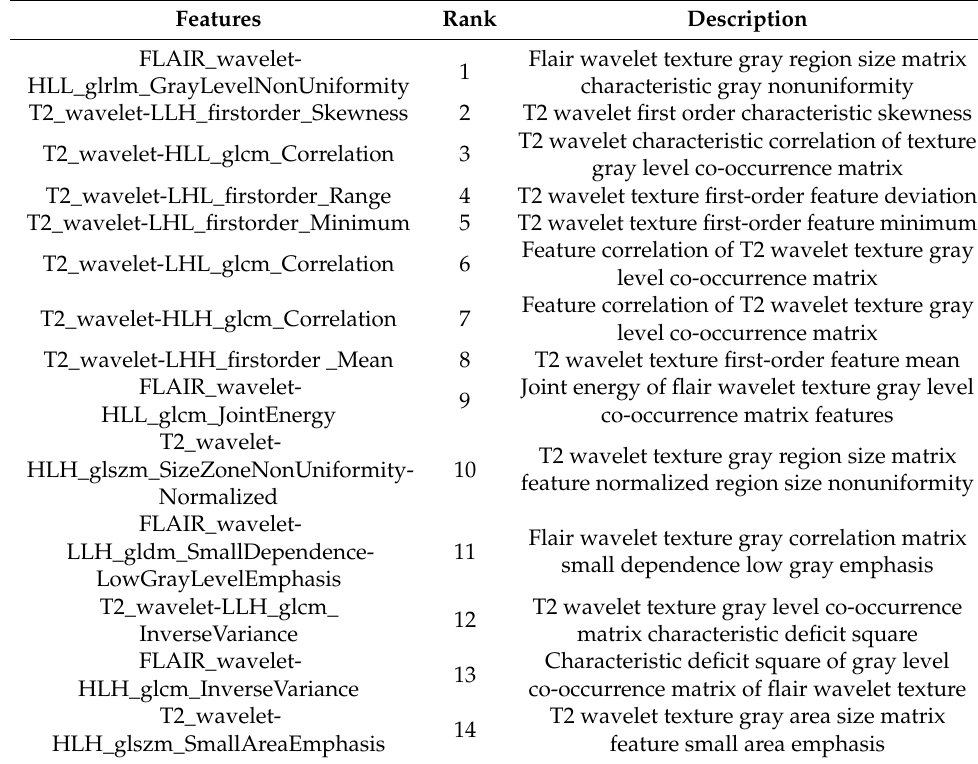
Table 5. The 14 radiomic features with the highest average feature importance generated by the optimal pipeline (T2+FLAIR multi-sequence